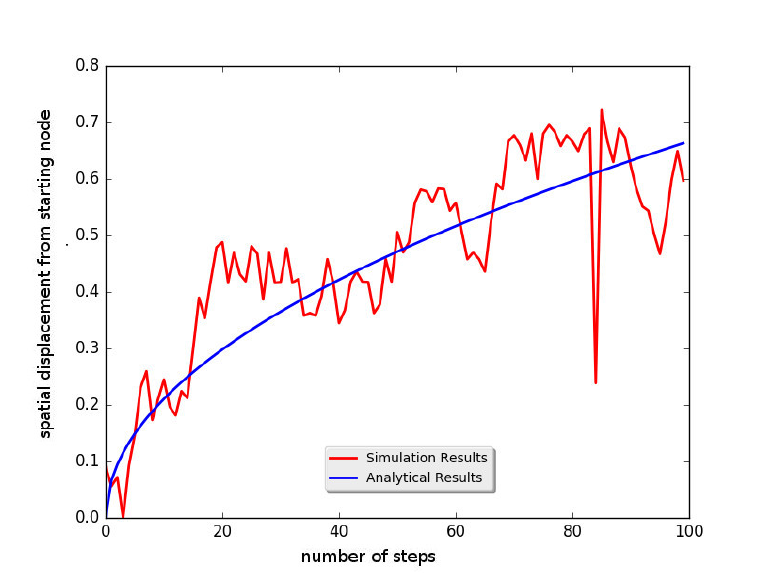
Figure 6. Random walker’s spatial displacement from the starting node. The blue line is from the analytical part of this study (i.e., Equation (1)), while the red one is from the simulation results. One can see that the walker is permitted to move in all directions; hence, the distance from the starting node could be either decreased or